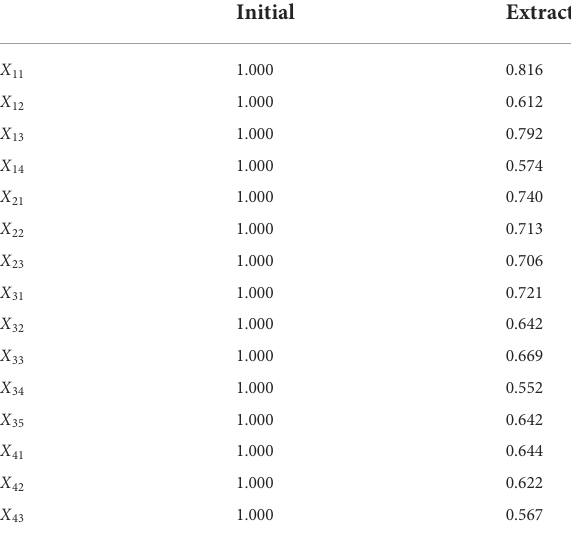
TABLE 4 Table of common factor